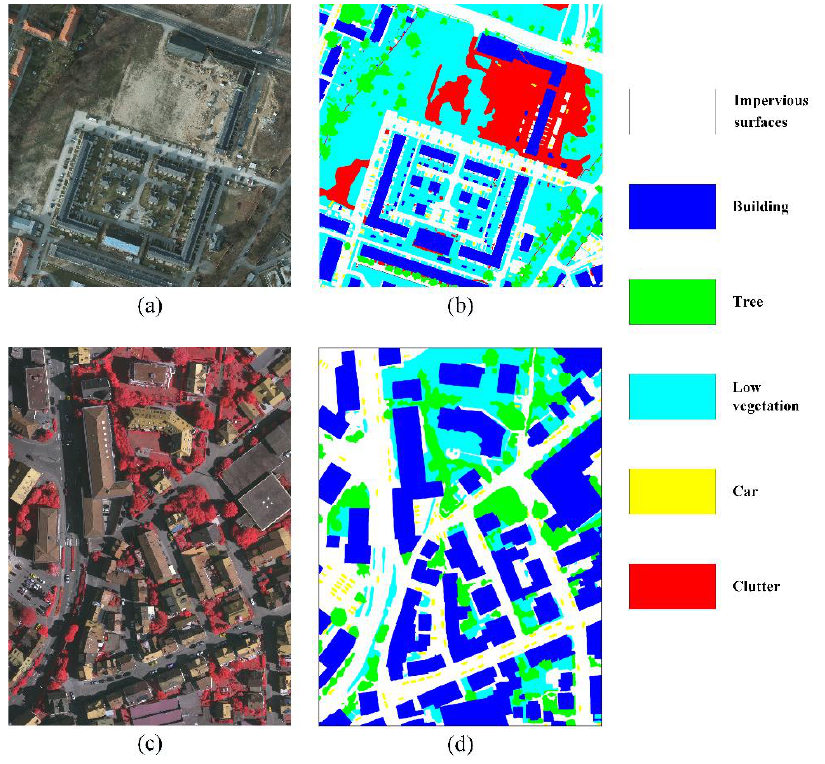
Figure 5. Illustration of ISPRS data samples. ( a ) Raw image of Potsdam dataset, ( b ) annotated ground truth of ( a ), ( c ) raw image of Vaihingen dataset, ( d ) annotated ground truth of ( c ).